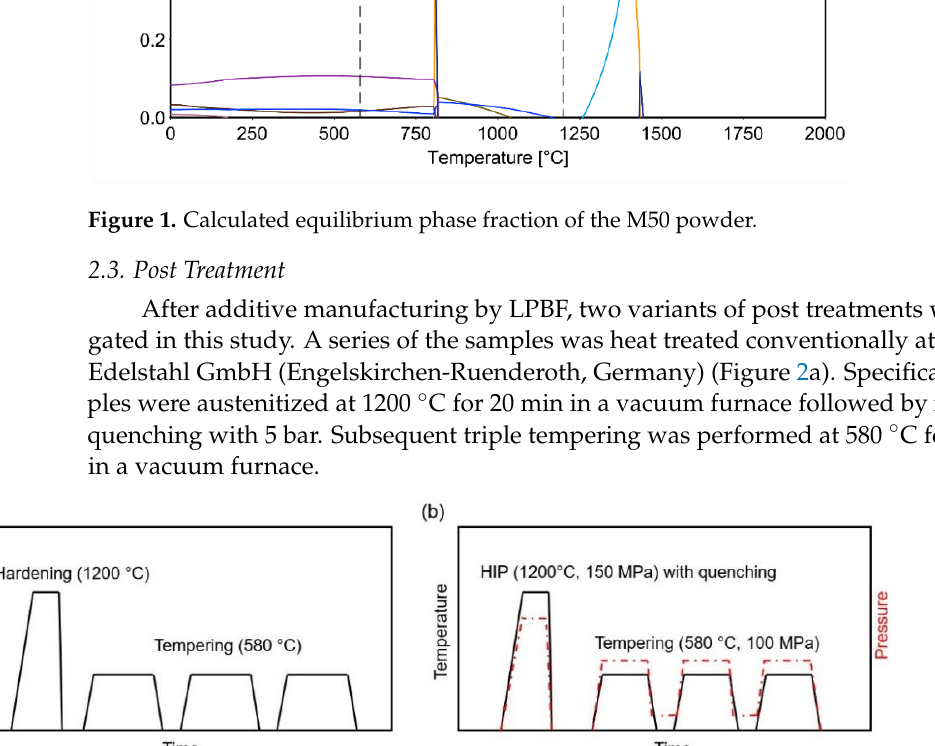
Figure 3. Cooling rate in dilatometer and HIP unit. 2.5. Microstructure The microstructure was characterized in as-built and post-treated conditions. Sam- ples were cut along the building direction and prepared by standard metallographic tech- niques with a finishing step of mechanical polishing using colloidal silica suspension. The porosity was determined by unetched sections with the magnitude of 100× by image anal- ysis. Ten sections at random positions for each sample were analyzed. The majority of pores were spherical and only the percentage of porosity was analyzed. For the micro- structure characterization, prepared samples were etched by V2A reagent for 10 s. The microstructural analysis was observed by an optical microscope and the scanning electron microscope Helios Nanolab G3 CX (FEI, Hillsboro, OR, USA) assembled with Secondary